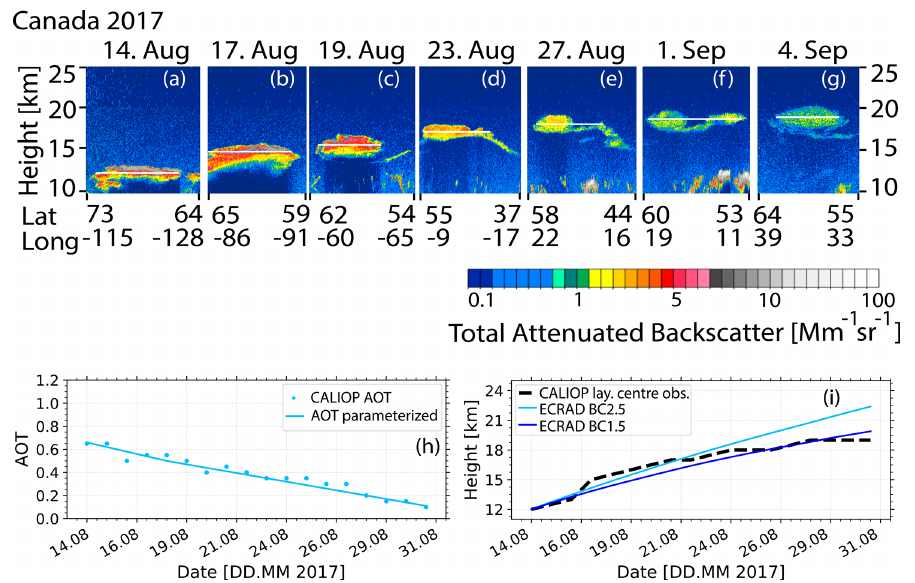
Figure 12. (a–g) Height–time display of the total 532nm (Rayleigh + particle) attenuated backscatter coefficient of a Canadian wildfire smoke layer observed with CALIOP on 6 different days within the 3-week period from 14 August to 4 September 2017. The white horizontal lines indicate the layer center height of the ascending smoke layer. In panel (h) , the AOT observations are given. The CALIOP layer-mean total attenuated backscatter coefficient was multiplied by a lidar ratio of 65sr (Baars et al., 2019) and by the layer thickness (retrieved from panels a – g ) in order to obtain the daily AOT (blue dots). The time series of AOT is parameterized (blue line). By using the parameterization in panel (h) , the heating rates and subsequent lofting rates are simulated, shown in panel (i) for 1.5% and 2.5% BC fraction and compared with the observed lofting rates (dashed black